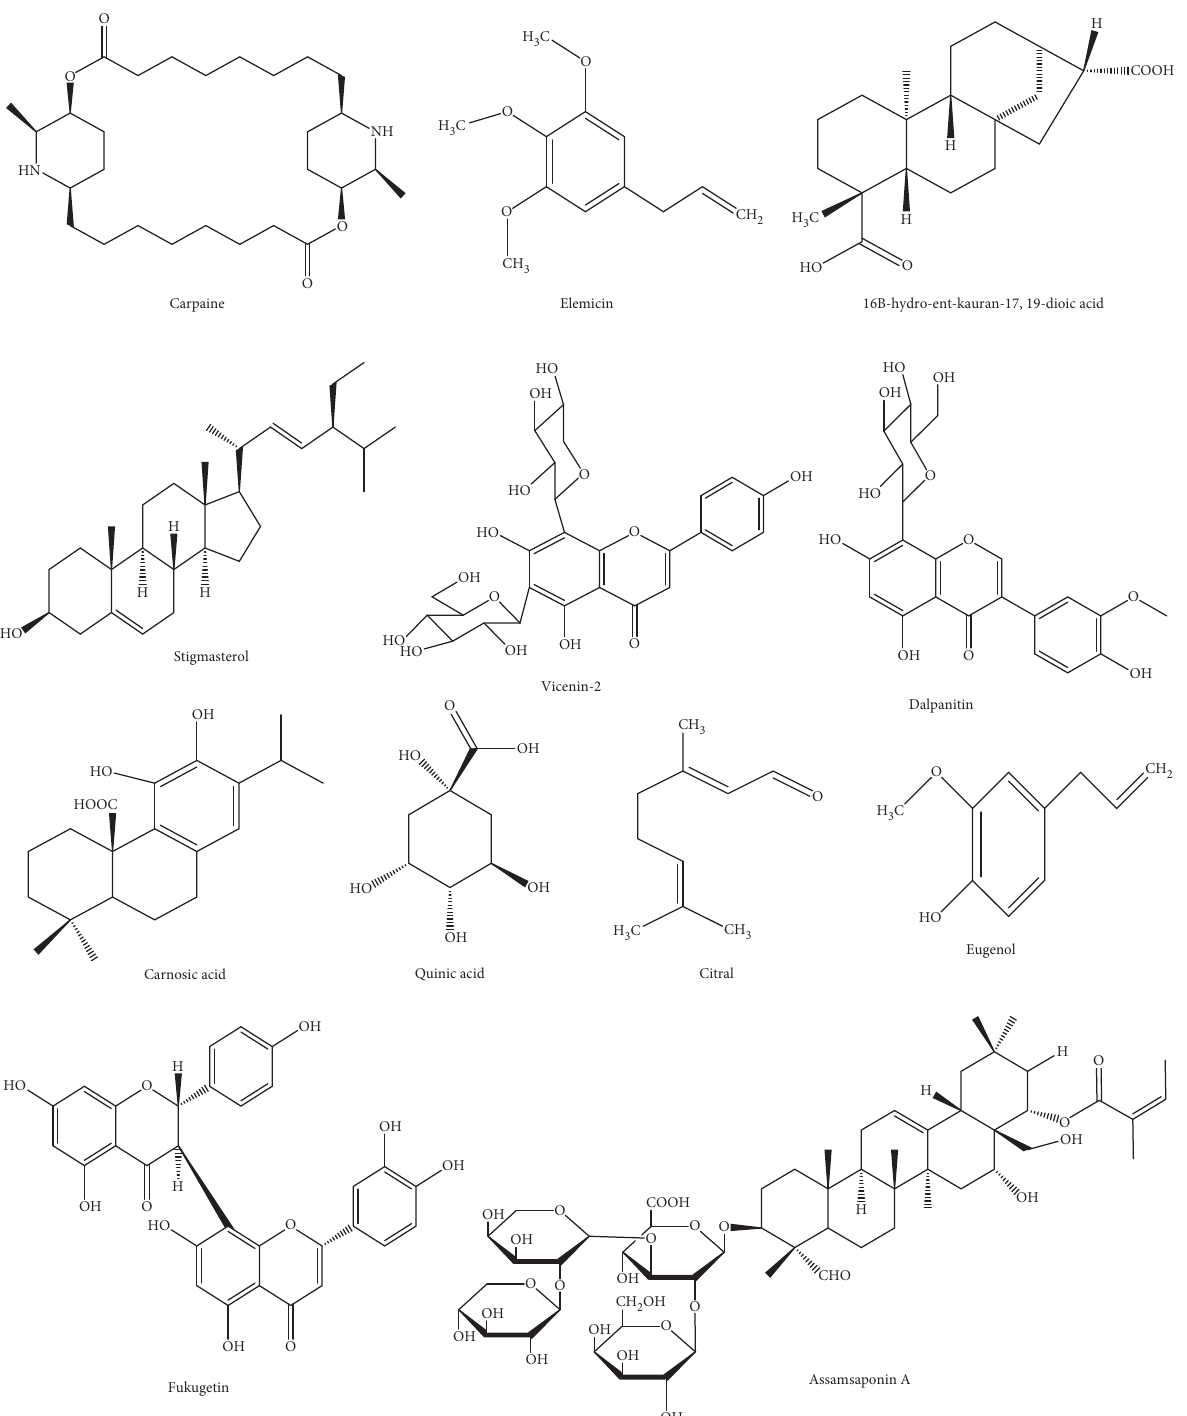
Figure 5: Natural antimicrobial–preservative